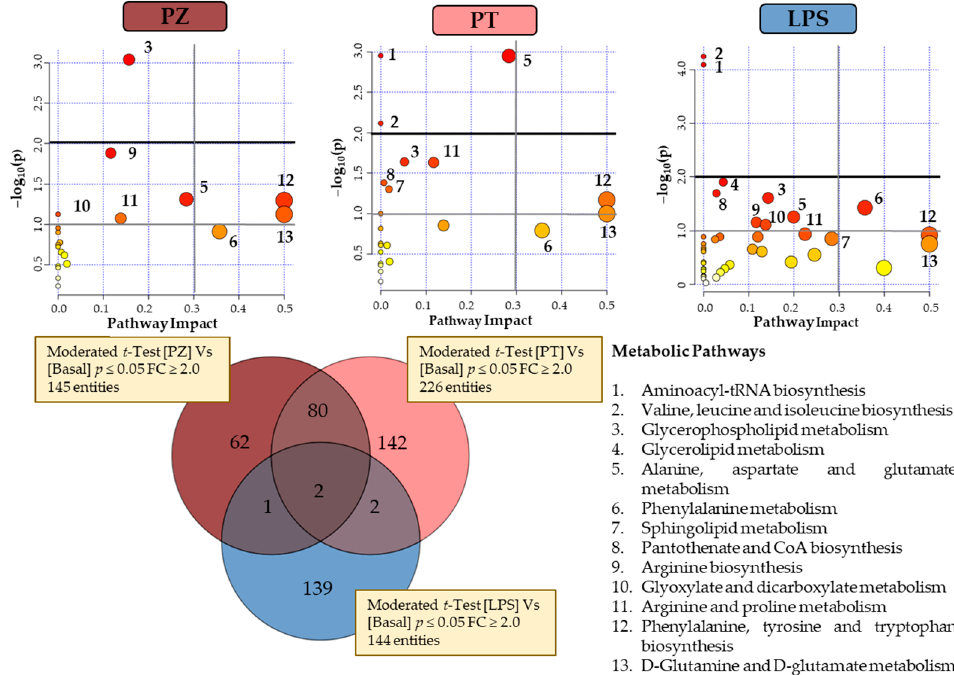
Figure 3. Venn diagram and metabolome overviews obtained from MetaboAnalyst pathway analysis of the subsequent evaluated conditions: PZ, phlorizin; PT, phloretin; and LPS, Lipopolysaccharide compared to BASAL. The top-pathways are ranked by the gamma-adjusted p values for permutation per pathway (y-axis) and the total number of hits per pathway (x-axis). The colour graduated from white to yellow, orange and red, circle size (large > small) as well as the values of both x and y increase represents the degree of significance.